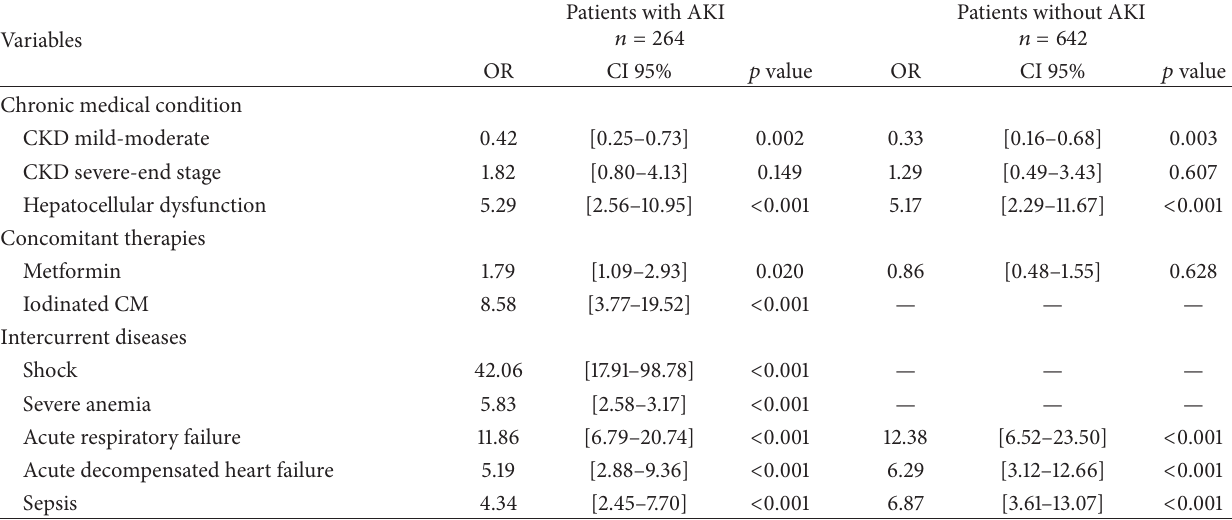
Table 4: Multivariate analysis with stratification variable: